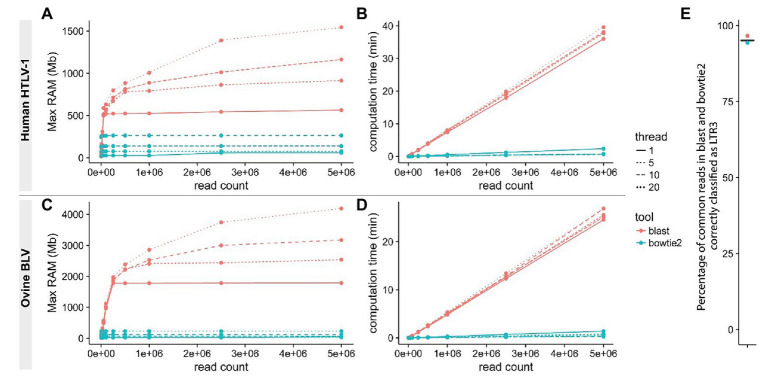
Improving read mapping processing speed. Reads from BLV (A,B) or HTLV-1 (C,D) clonality libraries containing 3'LTR-specific sequences were identified using either bowtie2 (-L 14 -N 1 -U; blue) or BLAST (red) with variable thread numbers (line types). RAM usage (A,C) and speed (B,D) were examined. The proportion of reads containing the appropriate 3'LTR sequence was compared between the two procedures (E).